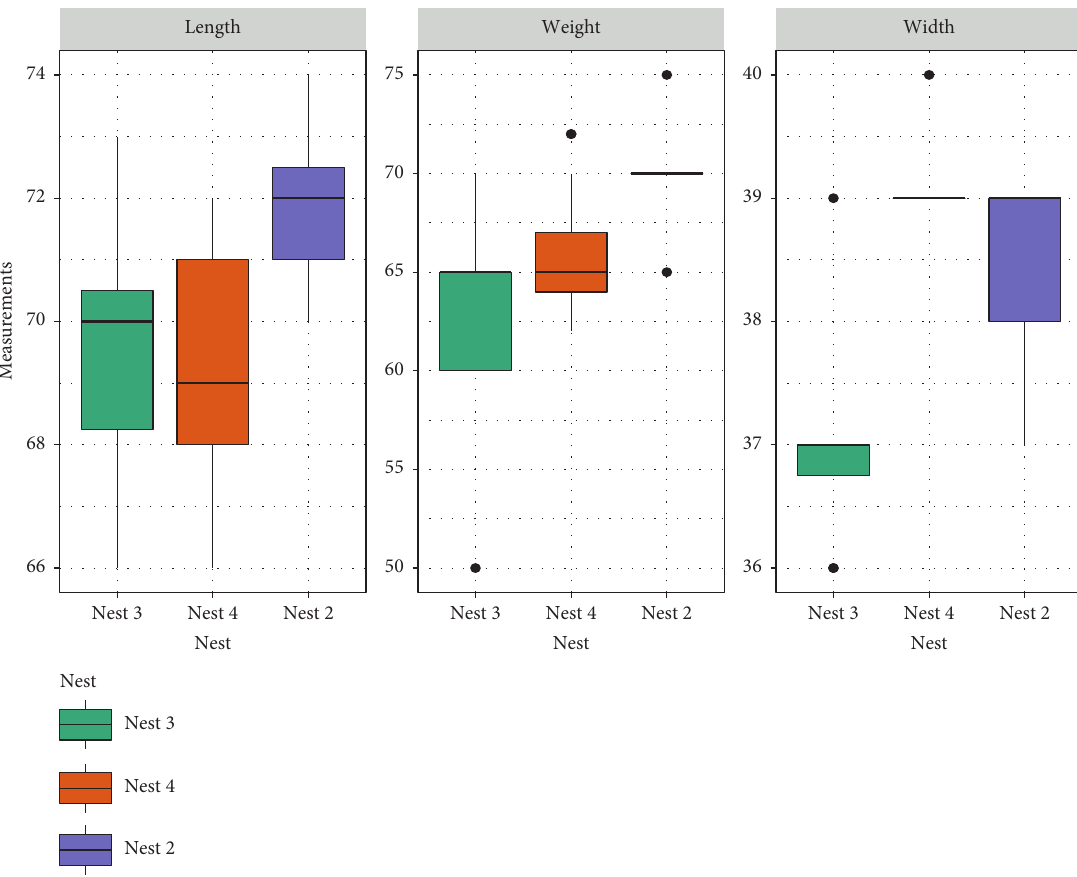
Figure 7: Comparison of means of egg measurements among three